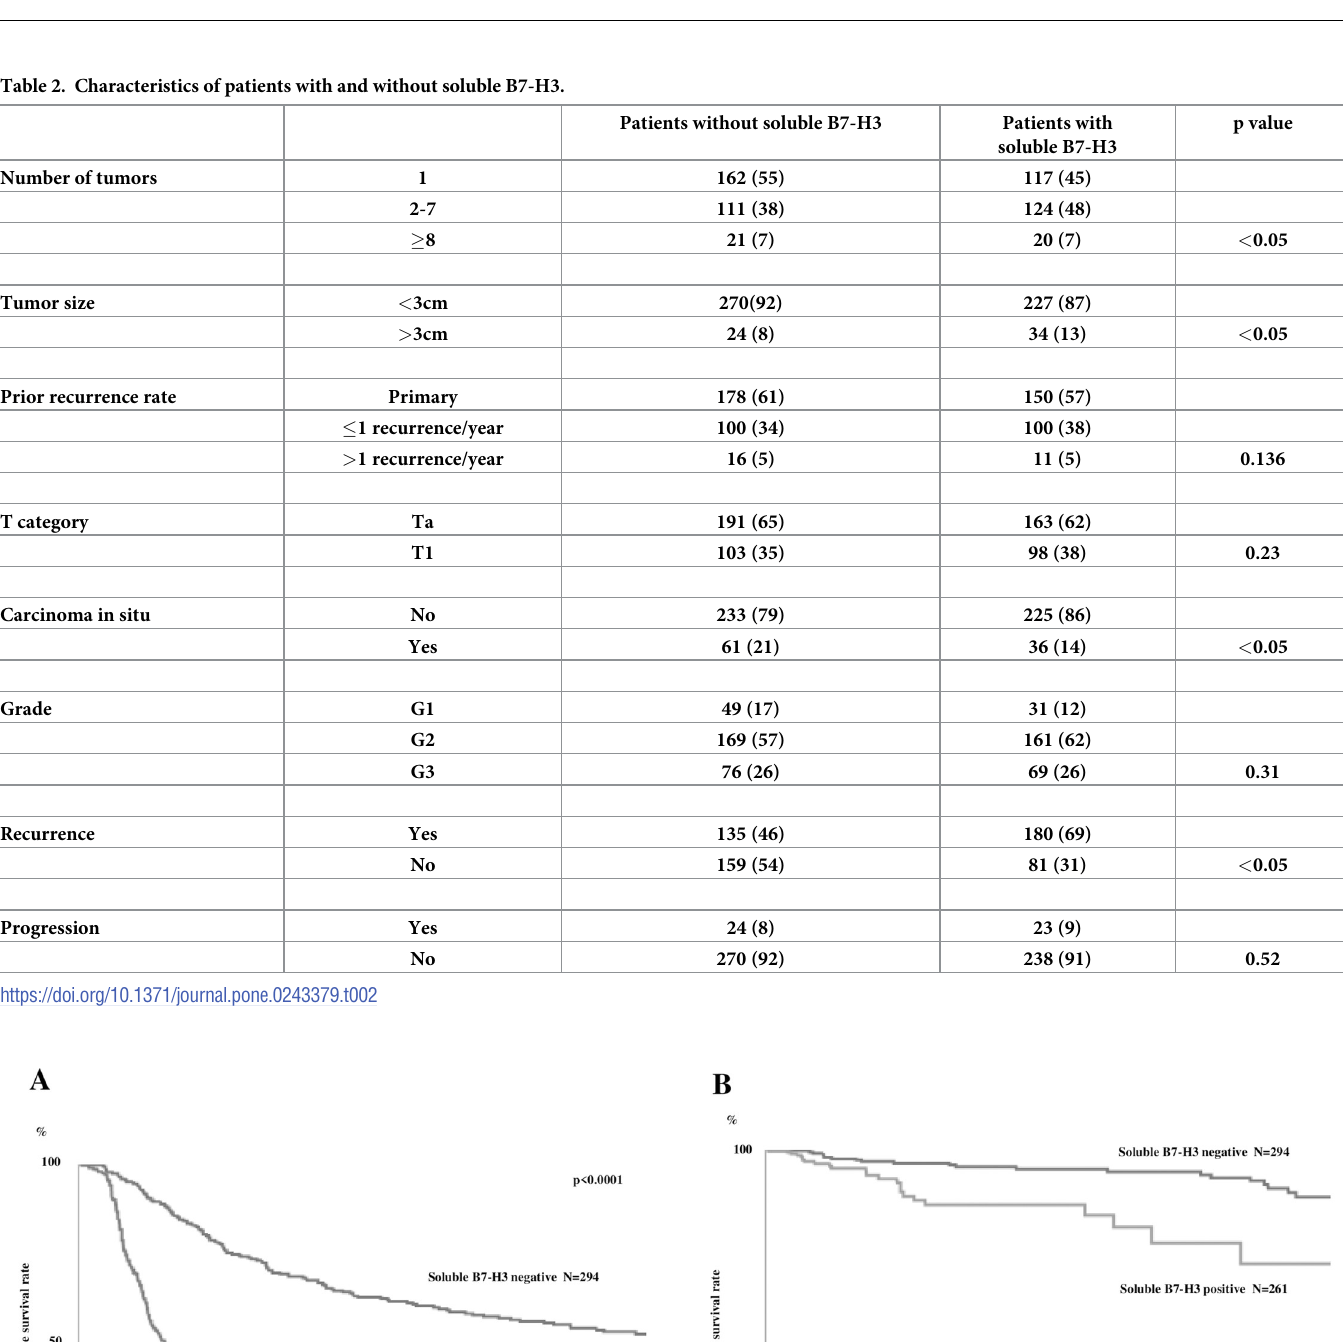
PLOS ONE | https://doi.org/10.1371/journal.pone.0243379 December11,